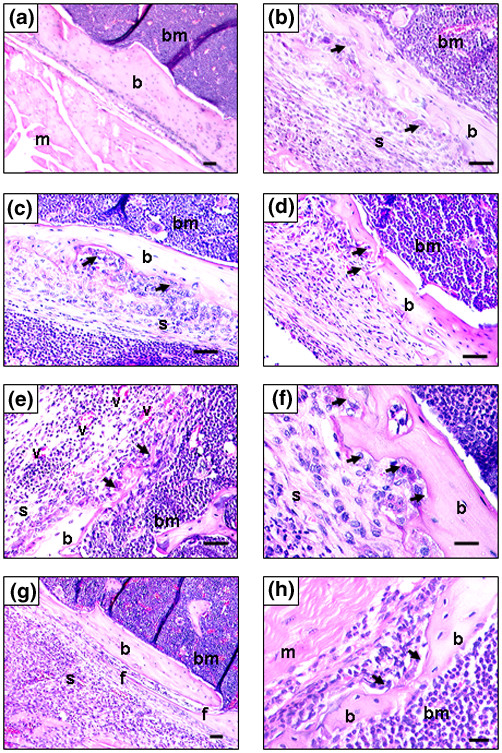
Bone damage caused by oncostatin M (OSM) in combination with either IL-1 or tumour necrosis factor alpha (TNF-α) in murine joints. Adenovirus vectors overexpressing murine OSM, IL-1 or TNF-α were injected intra-articularly into the right knee joints of mice at 5 × 106 plaque-forming units [pfu]/vector/joint. The left knee joints were injected with the empty control vector. All joints received a total of 1 × 107 pfu/joint, and all animals were sacrificed at day 7 following administration. Sections (5 μm) were stained with H&E. (a) Control, (b) OSM, (c) IL-1, (d) TNF-α, (e), (f) OSM + IL-1, and (g), (h) OSM + TNF-α. The joints showed a moderate (b–d) to severe (e–h) synovial hyperplasia and an infiltration of inflammatory cells. Marked synovial hyperplasia with angiogenesis was also seen with bone erosions (arrows) and bone fractures, with evidence of synovial invasion (e and g). b, bone; bm, bone marrow; f, bone fracture; m, muscle; s, synovial cells; v, blood vessel. (a)–(e), (g) Bar = 50 μm; (f), (h) bar = 20 μm.